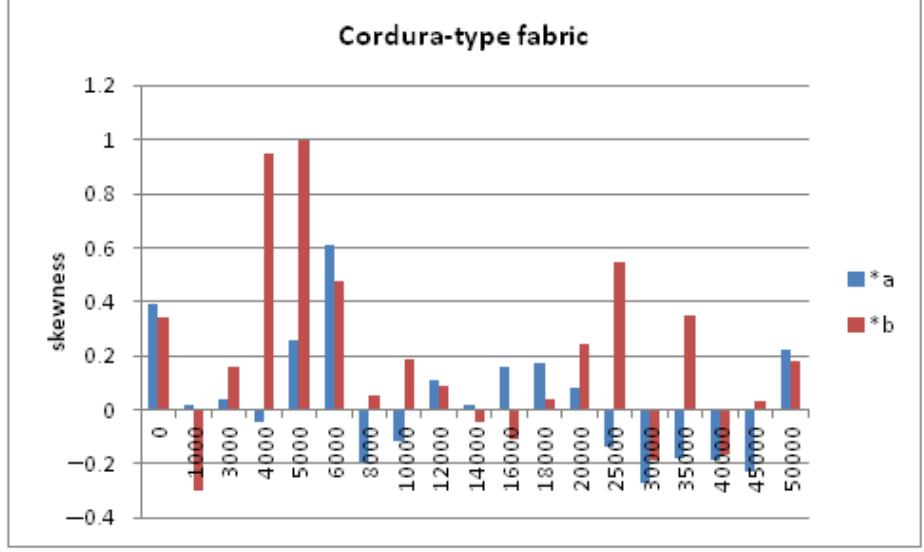
Figure 5. Skewness graph–Fabric